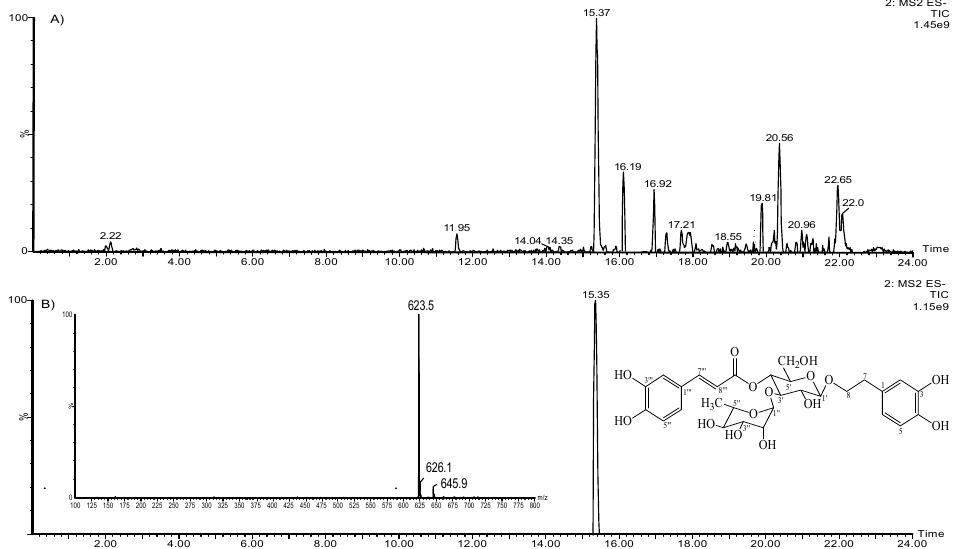
Figure 1. Aloysia polystachya hydroethanolic extract UPLC-MS chromatograms ( A ); acteoside negative ion electrospray ionization mass spectra (ESI/MS) ( B ).